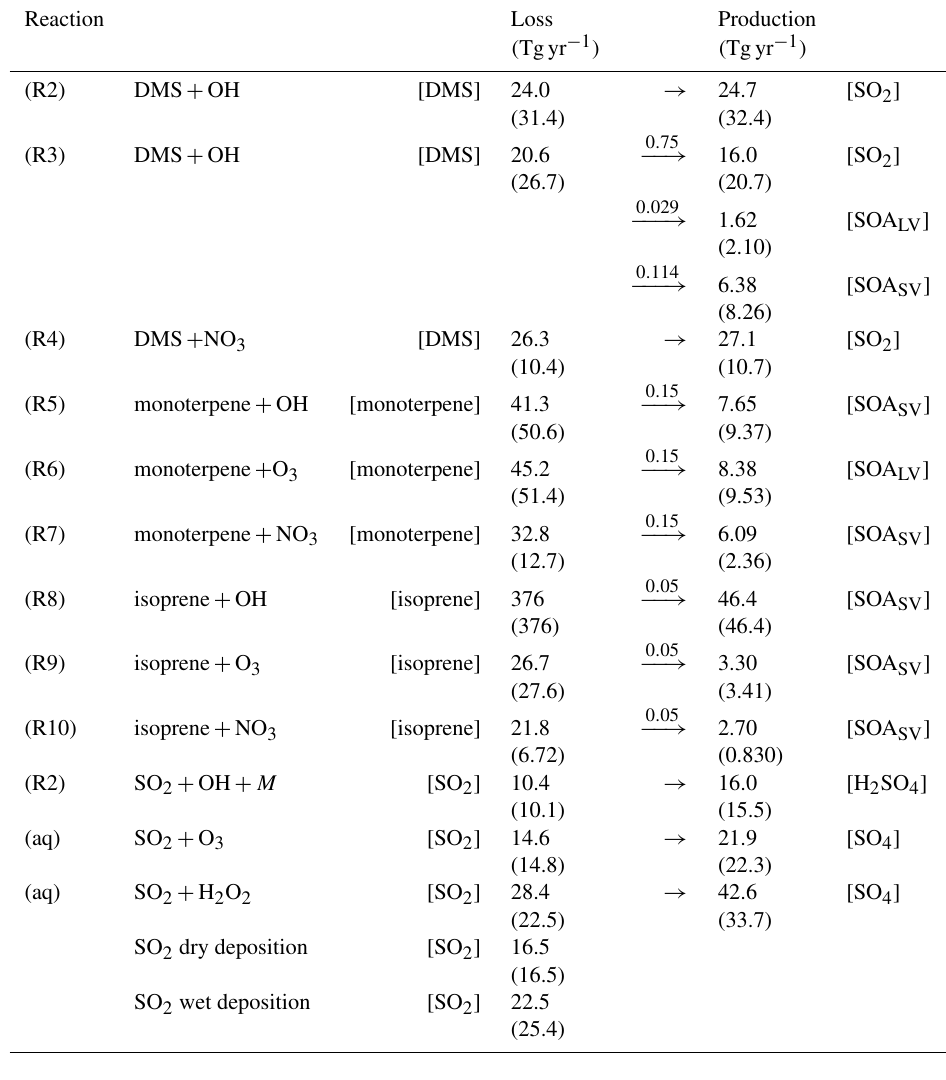
Table 5. Conversion rates using present-day (preindustrial) oxidants.